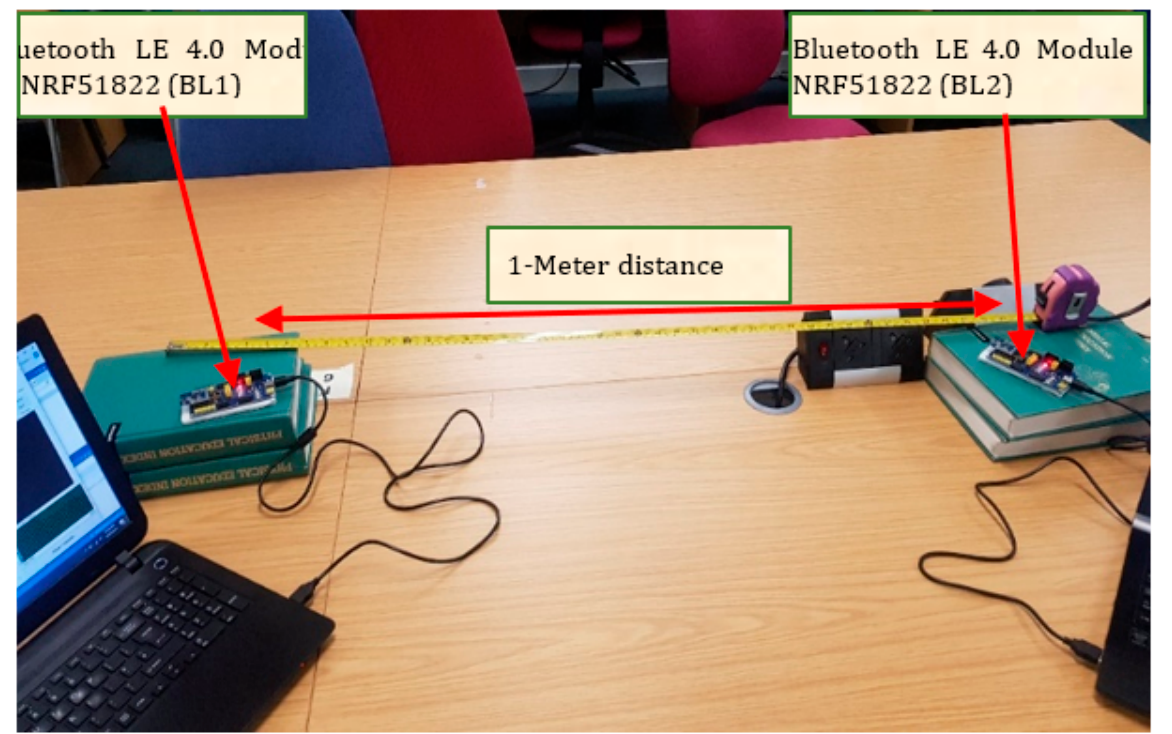
Figure 4. Respective Connection of Module Devices (BL1 source and BL2 destination) to PC1 and PC2.